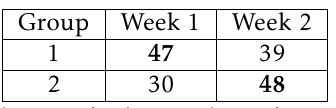
Table 1. Evolution of the number of works